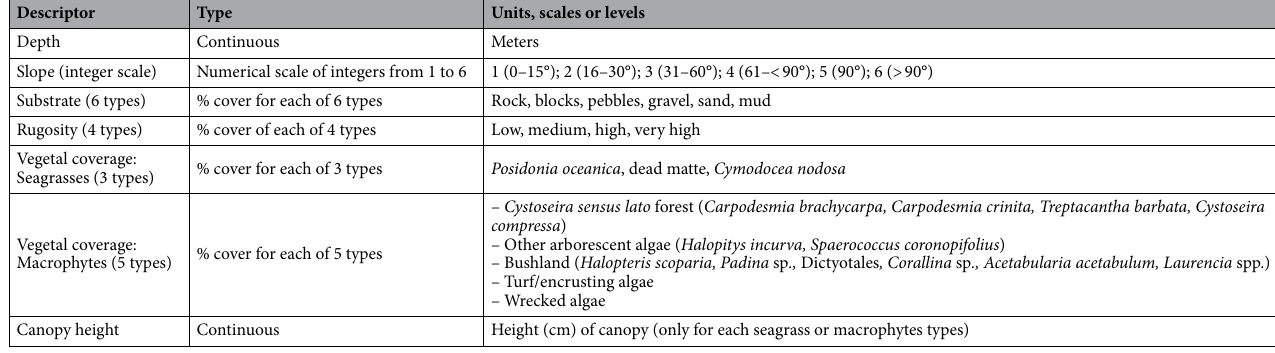
Table 2. Abiotic and biotic habitat descriptors of shallow coastal